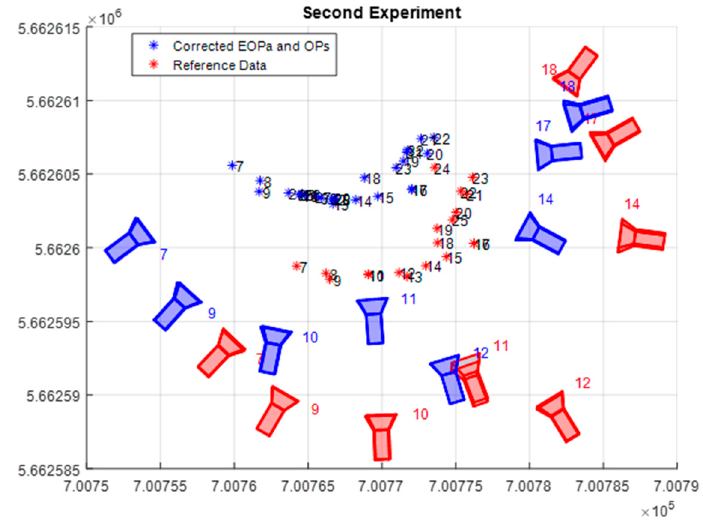
Figure 17. Second experiment final corrected initial EOPs and Ops.